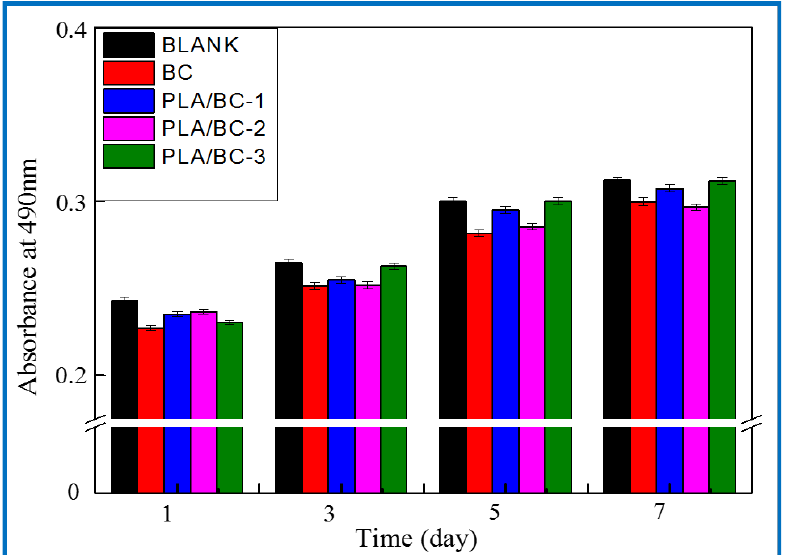
Figure 13. Proliferation of SCs after 1, 3, 5, and 7 d of culturing on BC membranes and PLA/BC composite scaffolds.